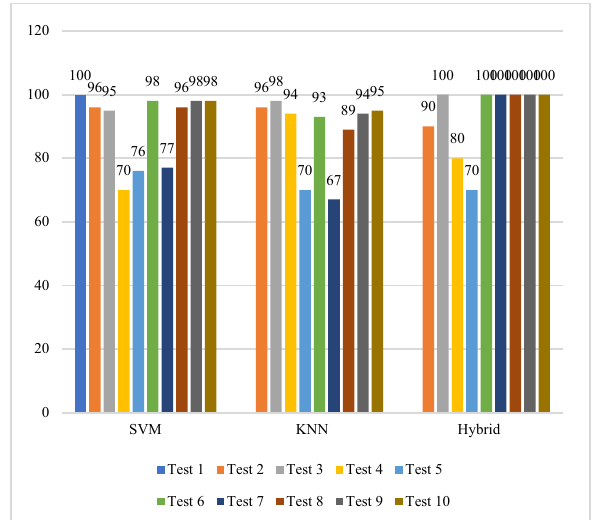
Figure 9. Predictive model testing has been conducted w.r.t. each classifier at ratio of 80% to 20%